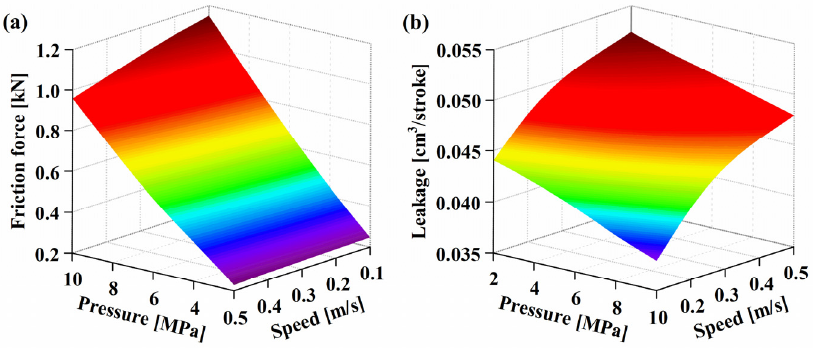
Figure 9. Variation of friction force and fluid leakage with sealed pressure and piston speed: ( a ) friction force, ( b ) fluid leakage.